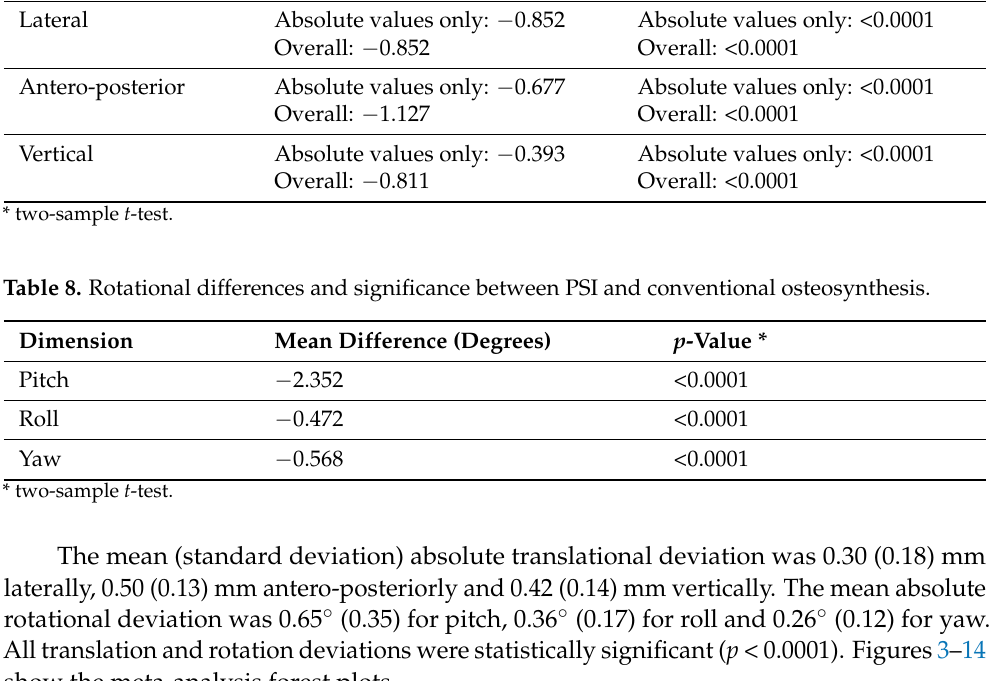
Table 7. Translational differences and significance between PSI and conventional osteosynthesis. Dimension